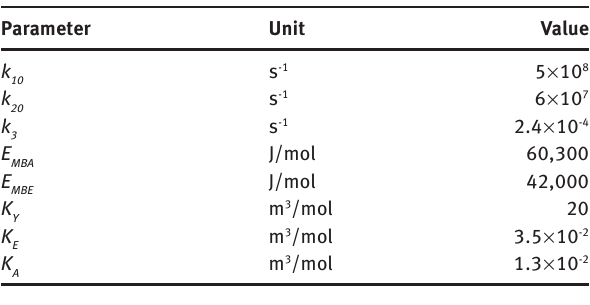
Table 1: Kinetic parameters for 2-methyl-3-butyne-2-ol (MBY) hydrogenation.